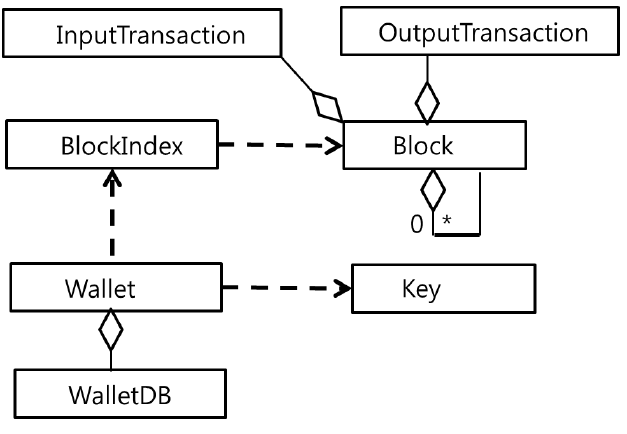
Figure 22. CBlock static model.